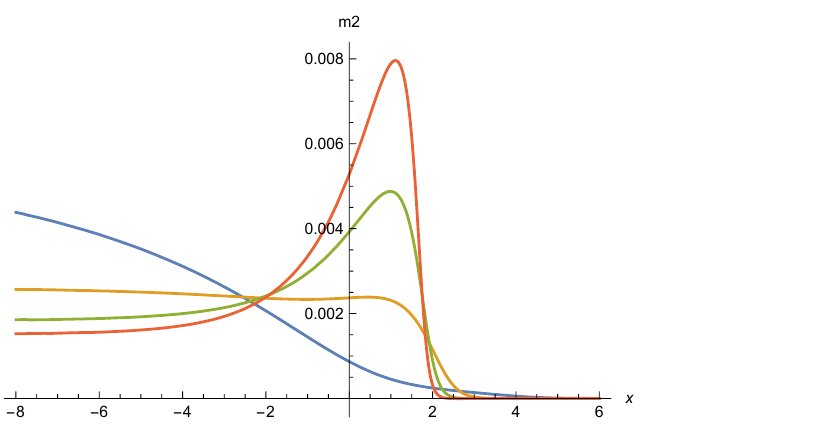
Figure A2. Mass term ˜ m 2 as function of x = ln ( ˜ ρ ) for nonvanishing Yukawa couplings. Parameters are as for Figure 9, with largest value at x = 0 for w 0 = 0.06 and smallest for w 0 = 0.042.